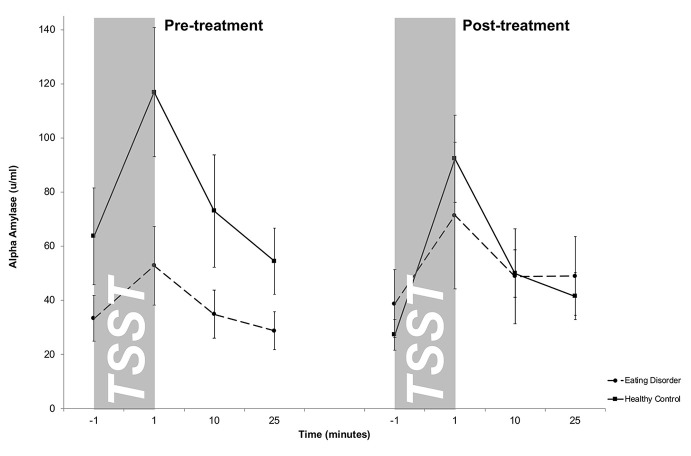
Salivary alpha-amylase (sAA) stress responses (means and standard errors) pre-treatment (left) and post-treatment (right) in patients with eating disorders and healthy controls (HC). While HCs showed an overall stronger salivary alpha amylase output pre-treatment, both groups displayed similar sAA responses post-treatment. For illustrative purposes raw values instead of log-transformed values are shown.